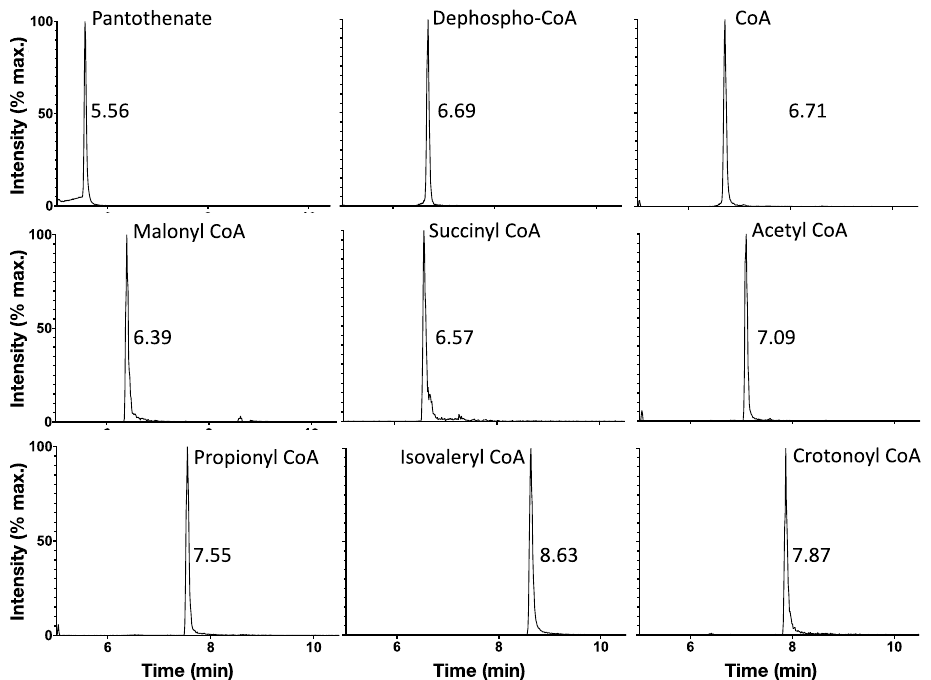
Figure 3. Ion-pairing UHPLC chromatography produces well-separated peaks for CoA biosynthetic intermediates and short-chain acyl CoAs. All eight compounds together with the internal standard (crotonoyl CoA) were injected at 1 μg/mL into the LC-MS/MS. Retention times are listed to the right of each peak. Liquid chromatography consisted of a reverse-phase gradient with solvents A & B (see Table 2) in addition to a Phenomenex Kinetex, 2.6 mm × 150 mm UHPLC C18 column. The quantitative MRM channel of each species was isolated and retention times were determined. Table 2. The following solvents were used during the chromatography: Solvent A, 5 mM ammo-